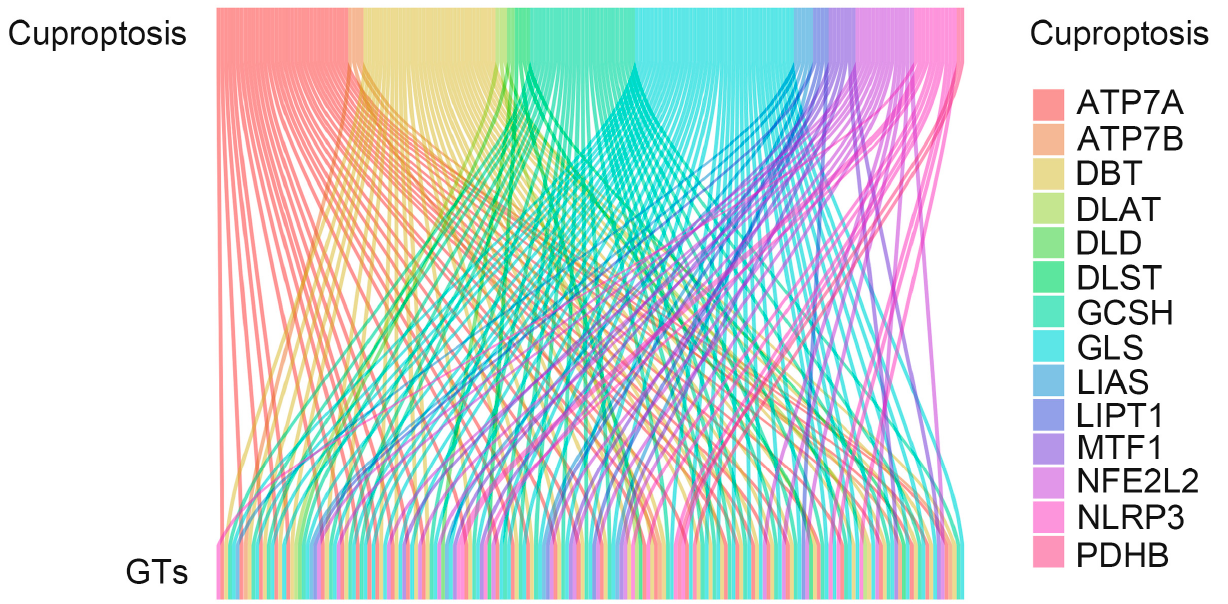
Figure 1. The correlation of cuproptosis-related genes with glycosyltransferases using the Sankey diagram.